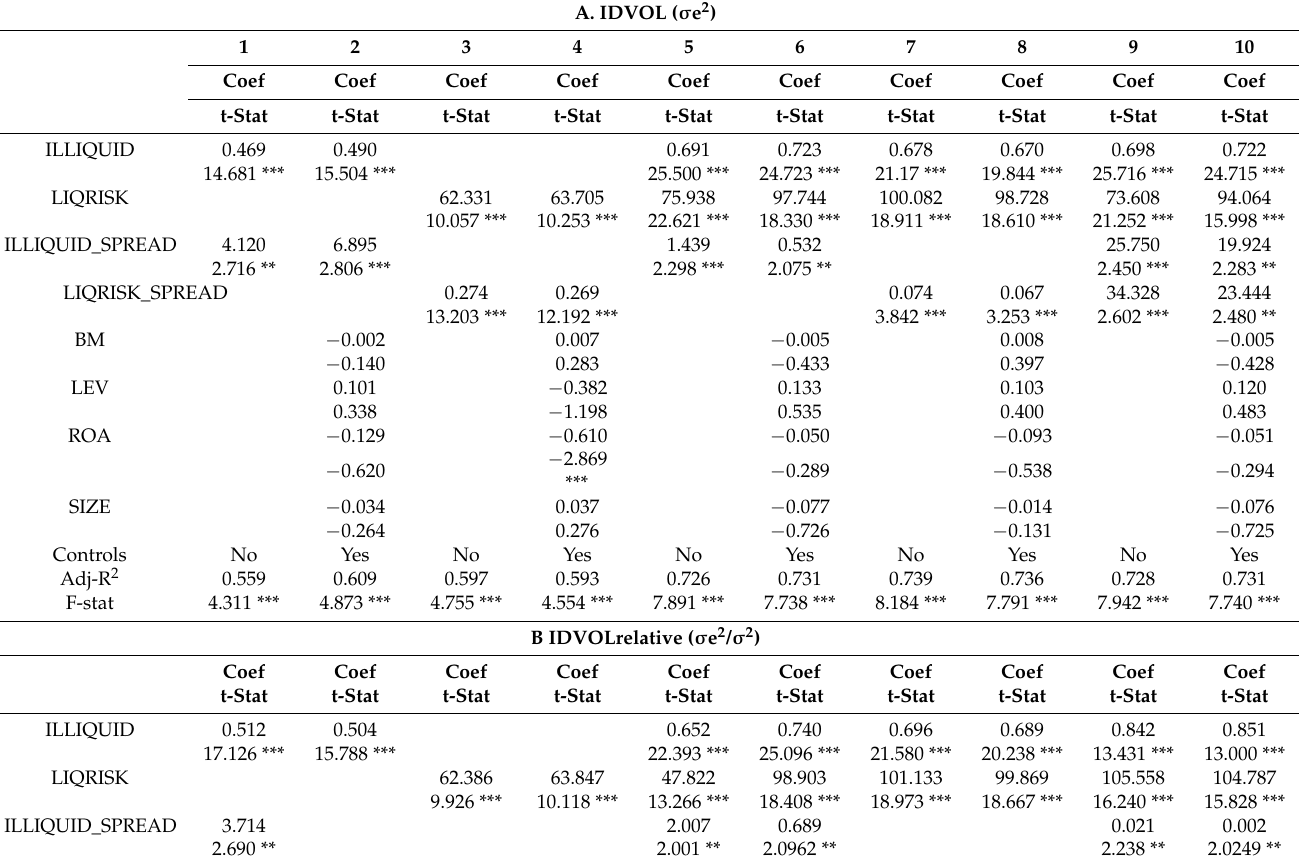
Table 9. Analysis of Equations (6a) and